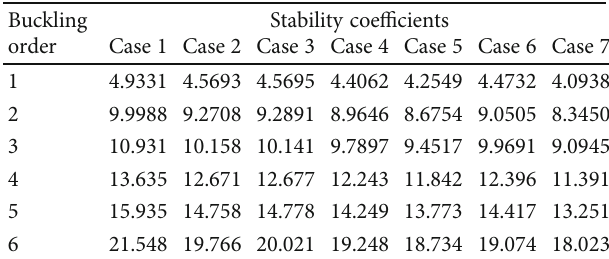
Figure 27: The sixth order buckling mode of arch bridge under case Table 1: The fi rst six order stability coe ffi cients of the main arch under various cases.